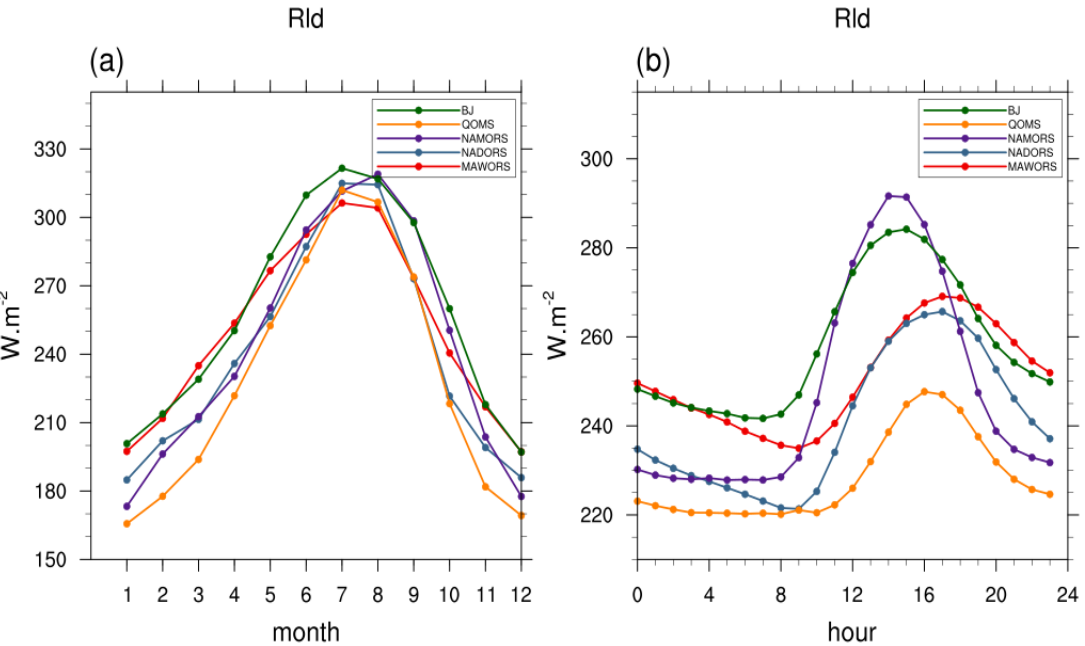
Figure 19. Annual variation of downward longwave radiation ( a ) and diurnal variation of downward longwave radiation ( b ) at each station.